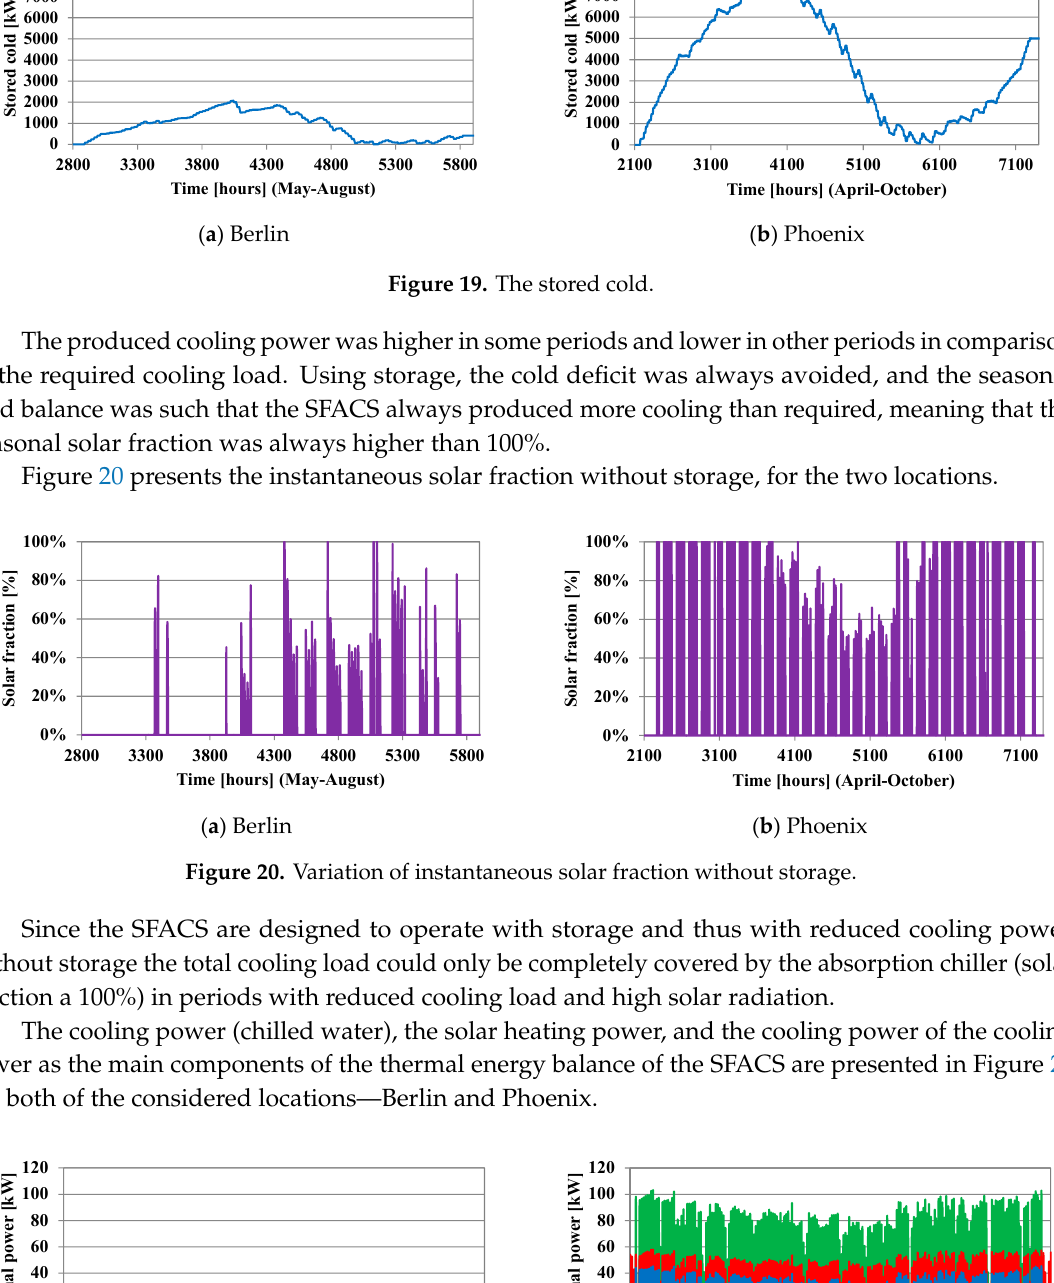
Figure 19. The stored cold.